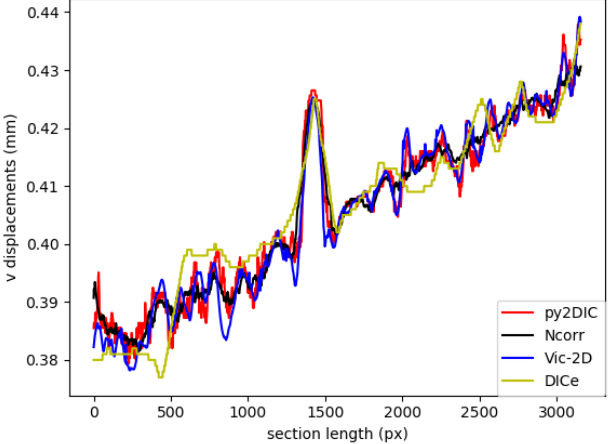
Figure 13. Comparison of v displacement along the section BB among py2DIC , Ncorr , Vic-2D and DICe